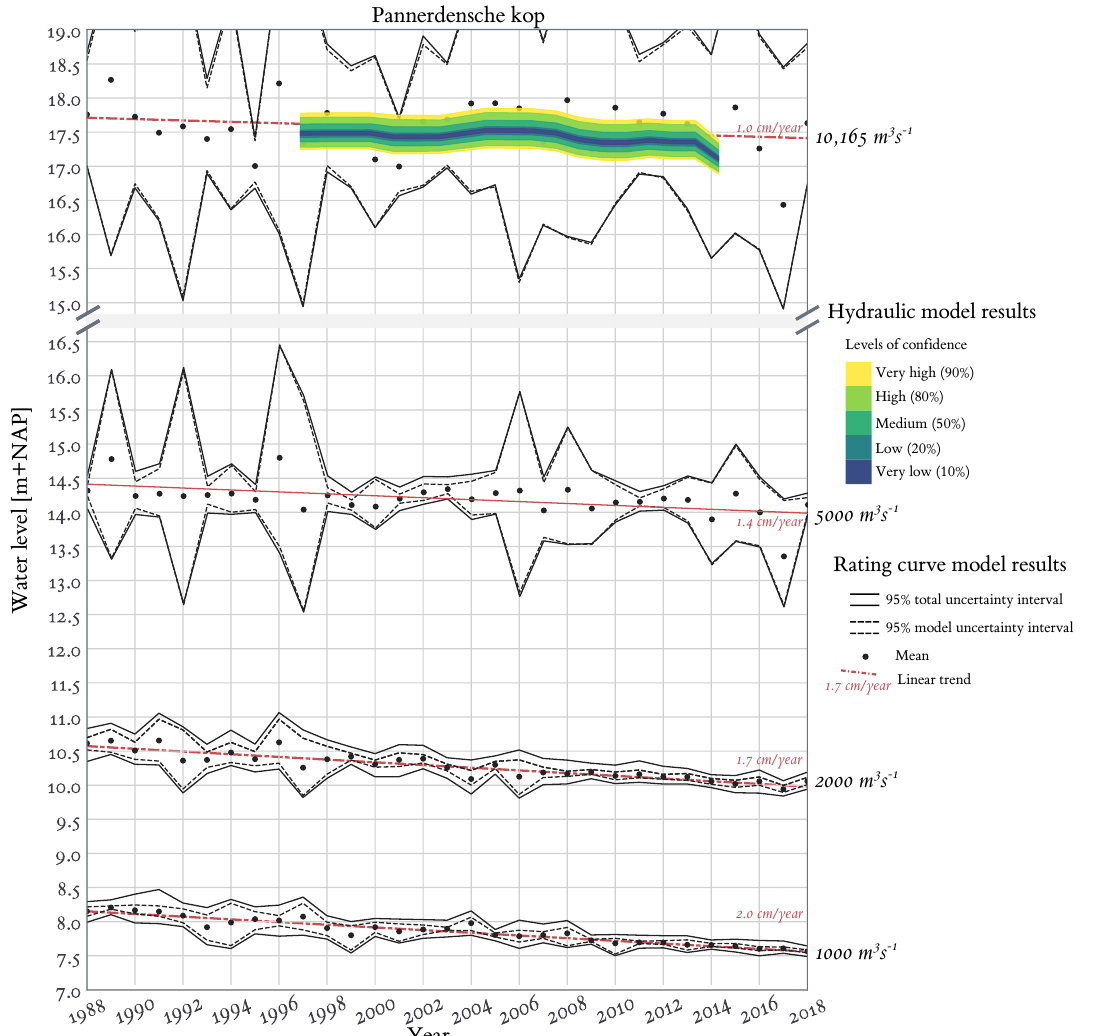
Figure 8. Water levels trends for main channel flow (1000 m 3 s − 1 ), bankful flow (2000 m 3 s − 1 ), floodplain flow (5000 m 3 s − 1 ) and extreme (10,165 m 3 s − 1 ) discharge at Pannerdensche Kop. Note the break in the vertical axis to prevent overlap of the uncertainty intervals at 5000 m 3 s − 1 and 10,165 m 3 s − 1